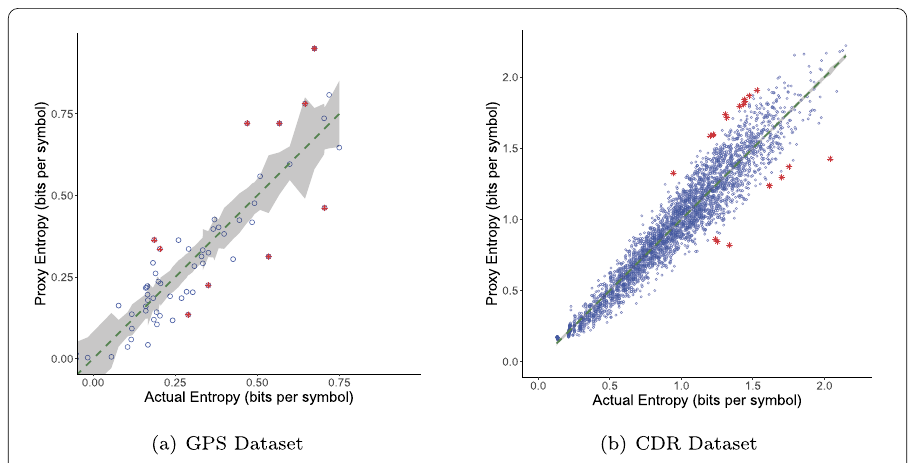
Figure 6 Entropy (in bits per symbol) fitted by the regression model (y-axis) versus actual entropy (x-axis), for both datasets in the next-cell prediction problem. The green, dashed line shows the regression line and the gray area shows the confidence interval. The red points are considered outliers and will be discussed separately. For the GPS dataset, we consider the RS